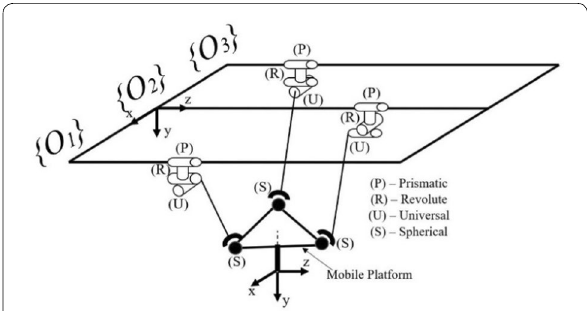
Figure 2 Schematic model of the 3-PRUS